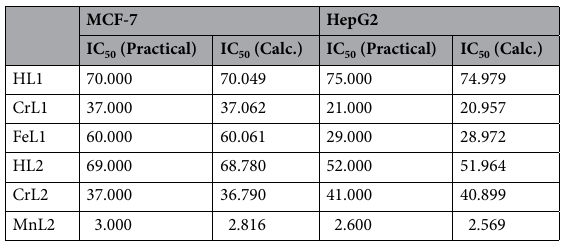
Table 14. Structure–activity relationship (SAR) model for practical and calculated IC 50 values in μM for anticancer activity against MCF-7 and